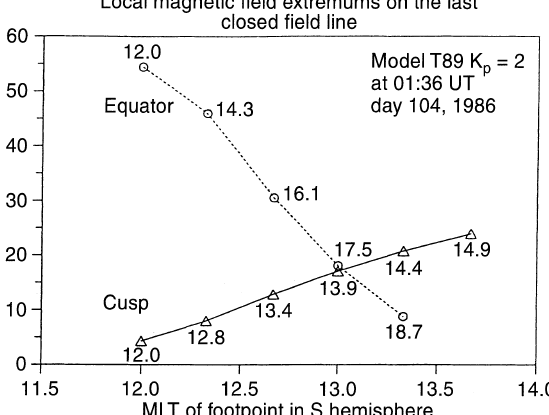
Fig. 2. Magnetic field values in equatorial region ( circles ) and high- latitude cusp ( triangles ) on the last closed field line against the local time of its ionospheric footpoint. The points are labelled with actual MLT where the field line crossed the cusp region or equatorial region. (Last closed field line was determined by tracing the field lines starting at fixed MLT meridian with a step 0.1 (cid:176) in geomagnetic latitude) Fig. 3. Positions of isotropic boundary latitude at the noon meridian (Fig. 1a) the field lines lie in the noon-midnight plane and the isotropic scattering occurs only in the high- latitude (cusp) minimum of the magnetic field. In the equatorial region there is a local maximum of the